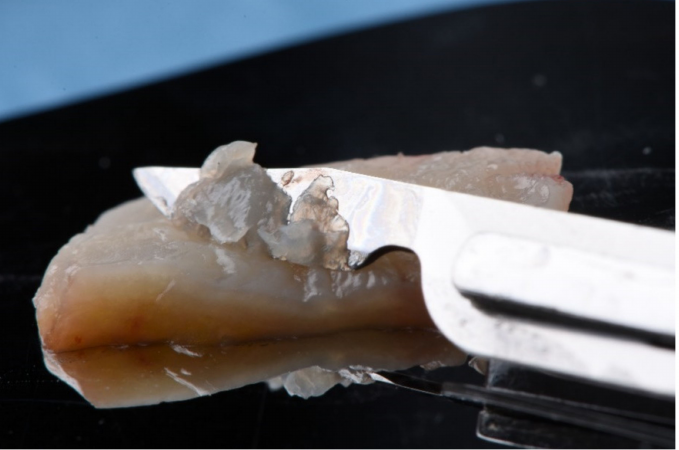
Figure 1. Deepithelialized free gingival